Question: Give a one-sentence summary of this figure.
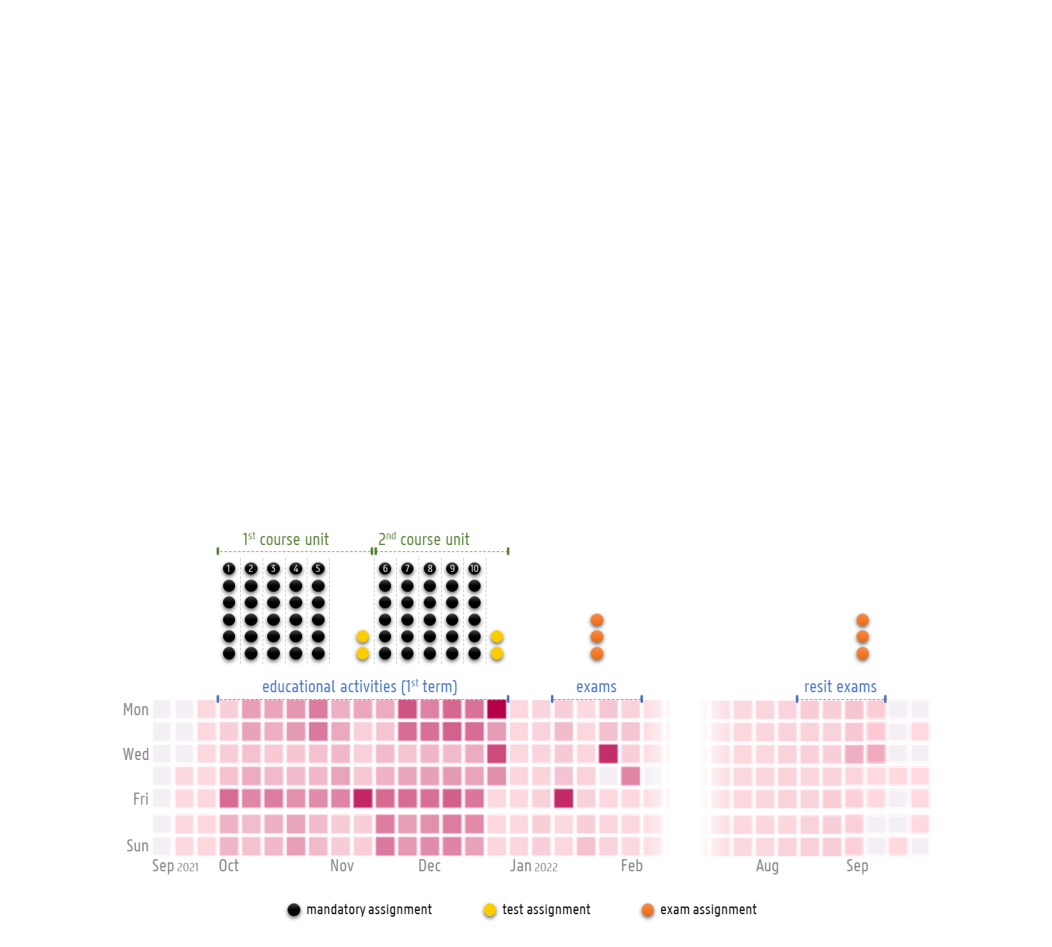
Answer: Top: Structure of the Python course that runs each academic year across a 13-week term (September-December). Programming assignments from the same Dodona series are stacked vertically. Students submit solutions for ten series with six mandatory assignments, two tests with two assign- ments and an exam with three assignments. They can also take a resit exam with three assignments in August/September if they failed the ﬁrst exam in January. Each series of mandatory assignments has a dedicated topic: (1) variables, expressions and statements, (2) conditional statements, (3) loops, (4) strings, (5) functions, (6) lists and tuples, (7) more about functions and modules, (8) sets and dic- tionaries, (9) text ﬁles, (10) object-oriented programming. Bottom: Heatmap from Dodona learning analytics page showing distribution per day of all 331 734 solutions submitted during the 2021–2022 edition of the course (442 students). The darker the color, the more solutions were submitted that day